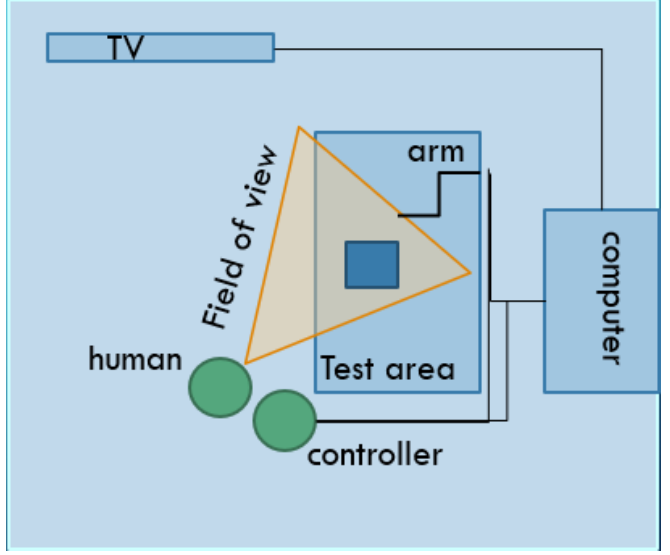
Figure 6. Top view of the test area, compromised of control devices, robotic arm and gripper, computer and TV